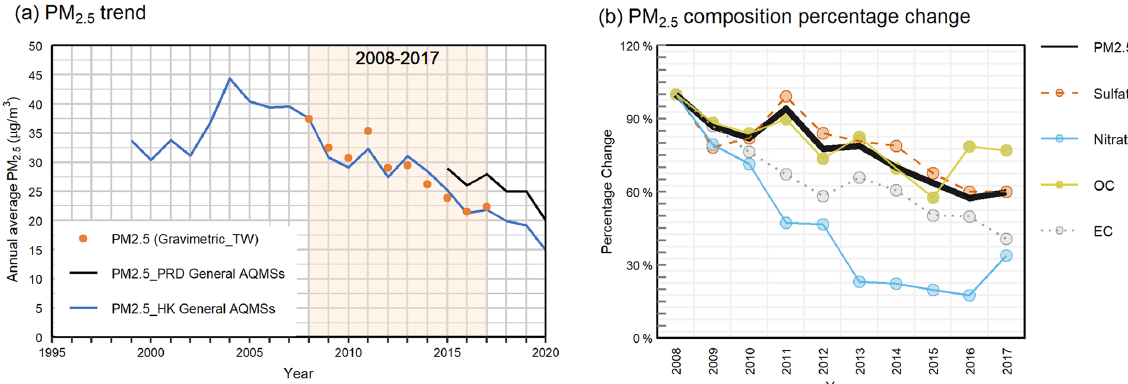
Figure 1. (a) Trend of annual average PM 2 . 5 in Hong Kong for the period of 1999–2020 and the PRD regionwide average PM 2 . 5 during 2015–2020. The regionwide annual PM 2 . 5 is the average of 23 monitoring stations in the PRD Regional Air Quality Monitoring Network, including three stations located in Hong Kong. The shaded period (2008–2017) has available PM 2 . 5 major components and select source tracers at Tsuen Wan (TW), an urban site in Hong Kong, with the yellow dots representing gravimetrically determined PM 2 . 5 concentrations from the collected filter samples at TW. (b) The percentage changes of PM 2 . 5 and its major composition at TW using 2008 as the base